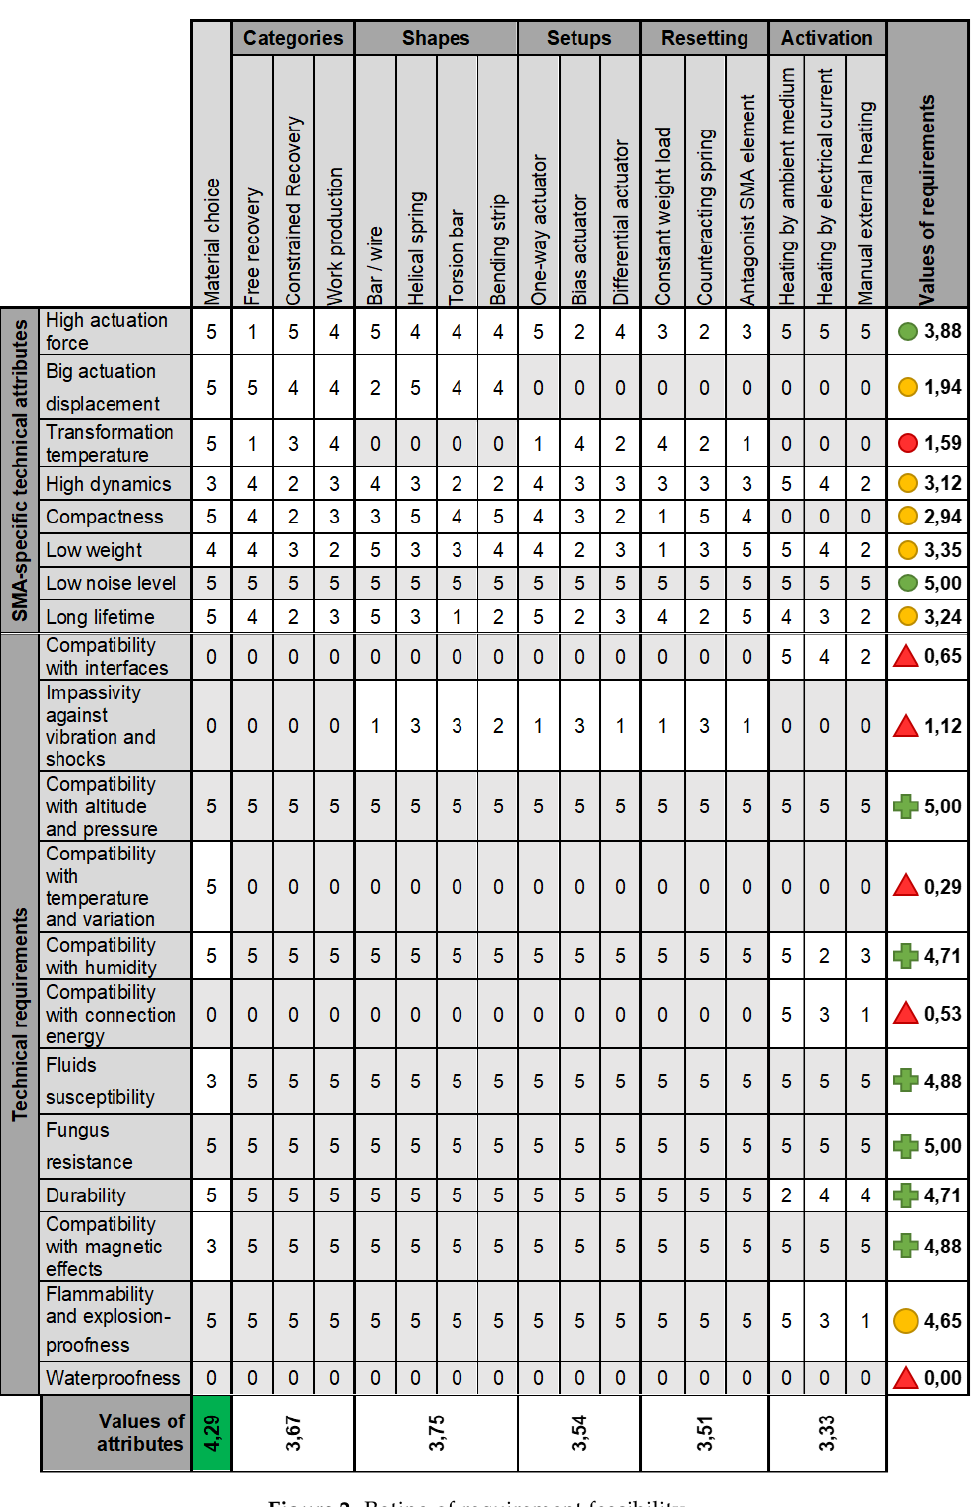
Figure 2. Rating of requirement feasibility.